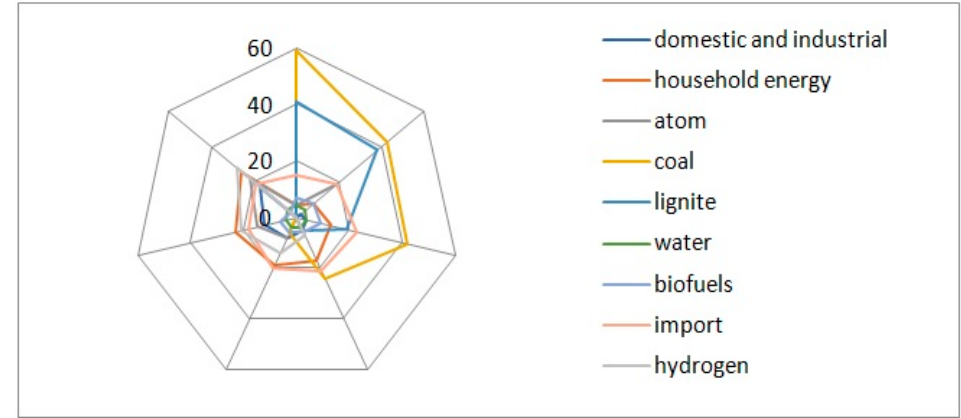
Figure 7. General statement of energy [42]. The highest upward trend was noticed in biofuels from 2025 to 2050, which is steadily and successively growing from smallest to the largest. In total, in CCGT and GT (Gas Turbines), to a small extent (2021–2025), high (2035–2040), medium (2040–2045) and low (2045–2050). We notice a downward trend in lignite and hard coal—from the higher (lower limit) and medium (lower limit) to the lowest, respectively, from 2021 to 2035. A moderate development tendency is visible in Onshore from 2025 to 2050 (it aims to increase from the beginning, increasing by 2.5 or 3 times by the end of 2050. Similarly, hydrogen—only from 2035 to 2050. Imports are insignificant (upper limit) from 2021 by 2050 on average by 0.3% with an upward trend until 2030 and from 2035 to 2050 with a downward trend (by an average of 1.2 points). From 2040, the atom begins at a small extent, doubled by 2045, and in 2050 is reduced by 1 / 4 from the previous period. It is estimated that renewable energy will increase up to 40% by 2030 and 70% by